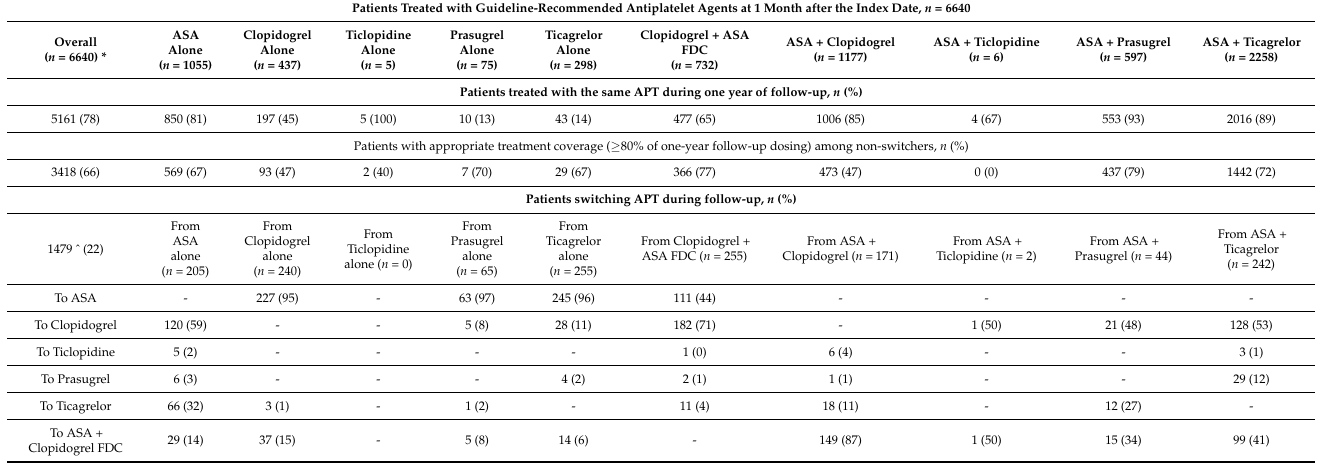
Table 2. Antiplatelet therapy regimens, appropriate coverage, and switching patterns during one-year follow-up in the acute coronary syndrome